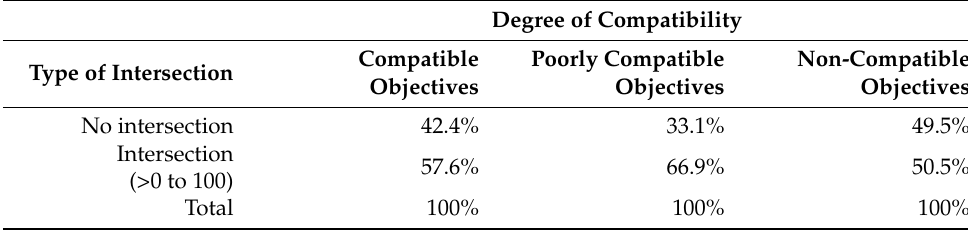
Table 8. Summary of the results of the interaction between compatibility and spatial intersection (Table 7 and Supplementary Materials). Type of Intersection